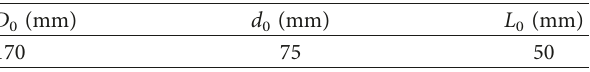
Table 2: Size of the pedestal.